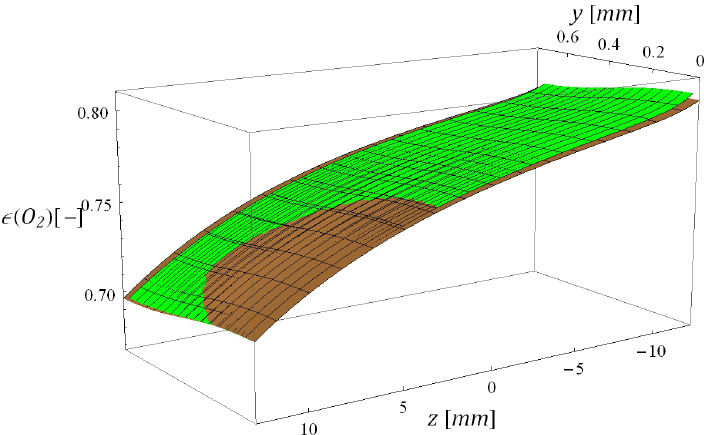
Figure 10. Cathode catalyst surface mole fraction of oxygen (cid:2035)((cid:1841) operational voltage. Green plot are CFD results and brown HAN-FC results.